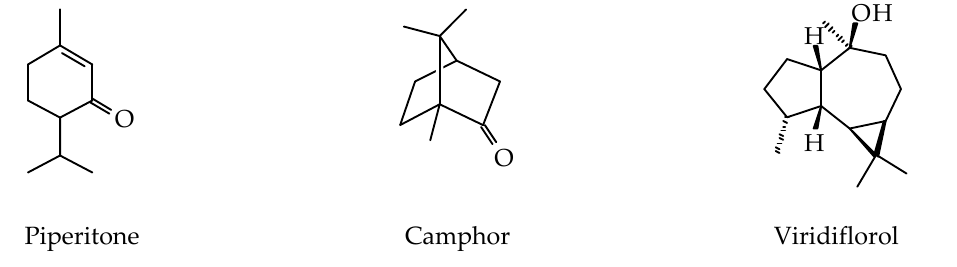
Figure 2. Chemical structures of the major components identified in the essential oil from Piper aduncum L. collected in Havana, Cuba. Table 1. Chemical composition of essential oil from Piper aduncum L. collected in Havana, Cuba.